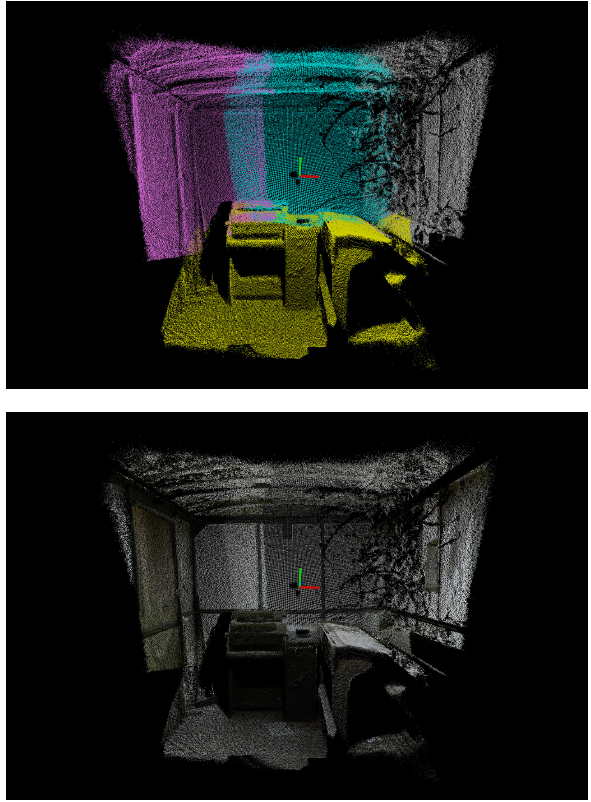
Figure 3. Combined point cloud created by the four RGB-D sensors. Top: Point cloud colored by scan id. Bottom: Point cloud with color data.